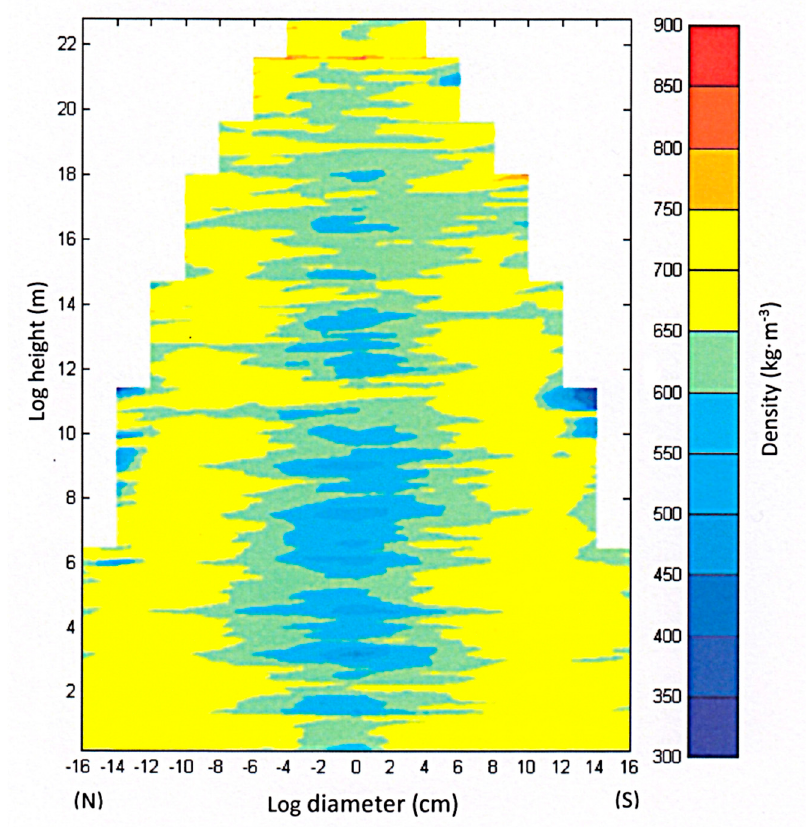
Figure 9. Map of density distribution in the studied wood of silver birch.